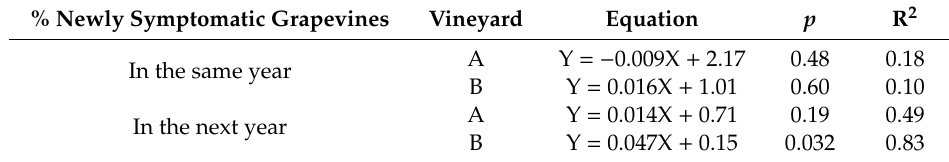
Table 3. Regressions between captures of Hyalesthes obsoletus on herbaceous vegetation inside the vineyards (2014–2018) and percentage of newly GY symptomatic grapevines in the same (2014–2018) and in the next year (2015–2019). % Newly Symptomatic Grapevines